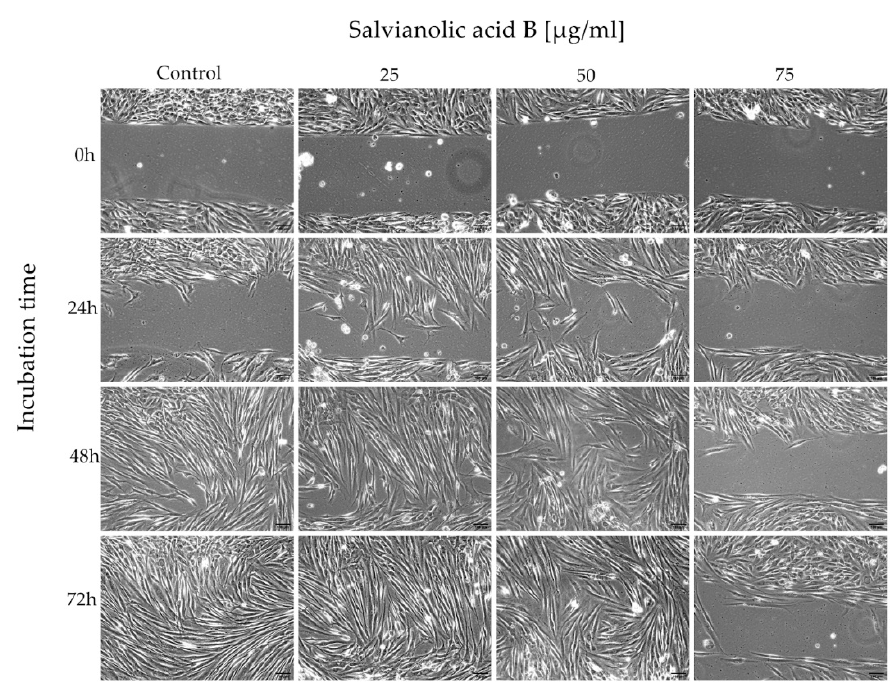
Figure 2. Human gingival fibroblasts after 24, 48 and 72 h of incubation. ImageJ made it possible to clearly visualize the process of space overgrowing with